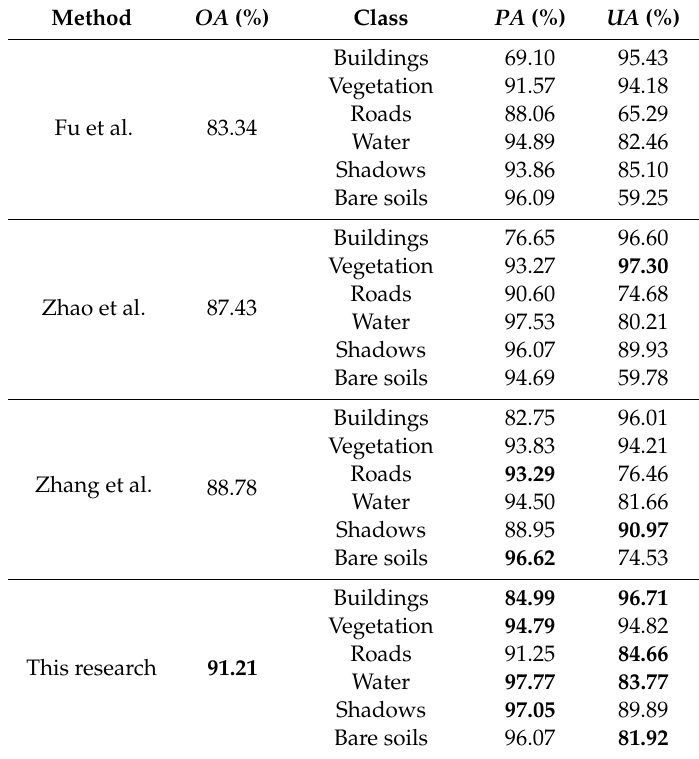
Figure 24. Classification results comparison of ( a ) Fu et al., ( b ) Zhao et al., ( c ) Zhang et al. and ( d ) our method on Zurich dataset. Table 4. Comparison of classification accuracies on Beijing dataset (bold numbers represent the highest OA , the highest PA of each class, and the highest UA of each class).